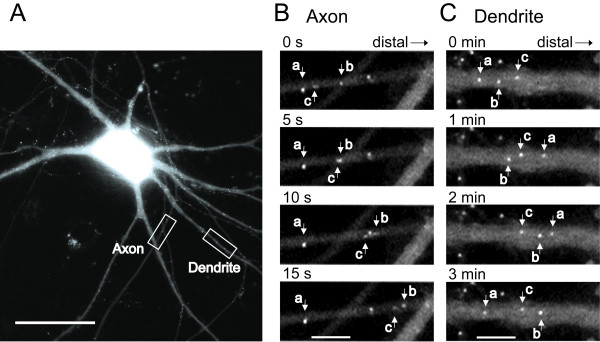
Movements of BDNF-GFP puncta in an axon and dendrites of a living neuron. A, Image of a cortical neuron which expressed BDNF-GFP in soma, axon and dendrites. Time-lapse images in each square along an axon and a dendrite are magnified and shown in B and C, respectively. Scale bar, 50 μm. B, Moving (b and c) and non-moving (a) puncta in the axon. Each image was taken at a time point indicated at the top of each figure. Right is the distal side of the axon. Scale bar in the bottom image indicates 5 μm and applies to all the images in B and C. C, Moving (a and b) and non-moving (c) puncta in the dendrite. Right is the distal side of the dendrite. Each image was taken at a time point indicated at the top of each figure.